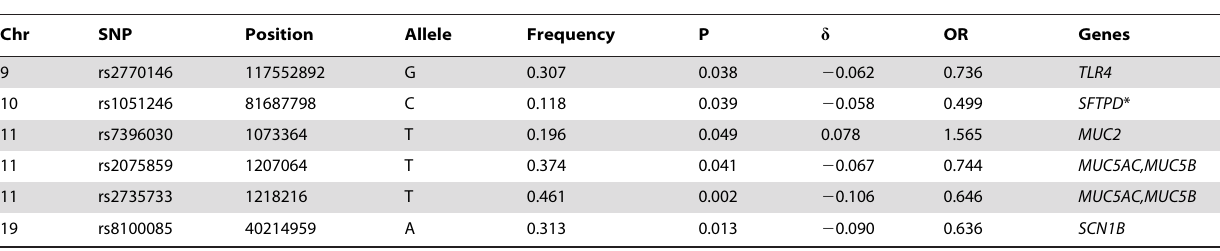
Table 3. GDT association results (P , 0.05) for COME/ROM.